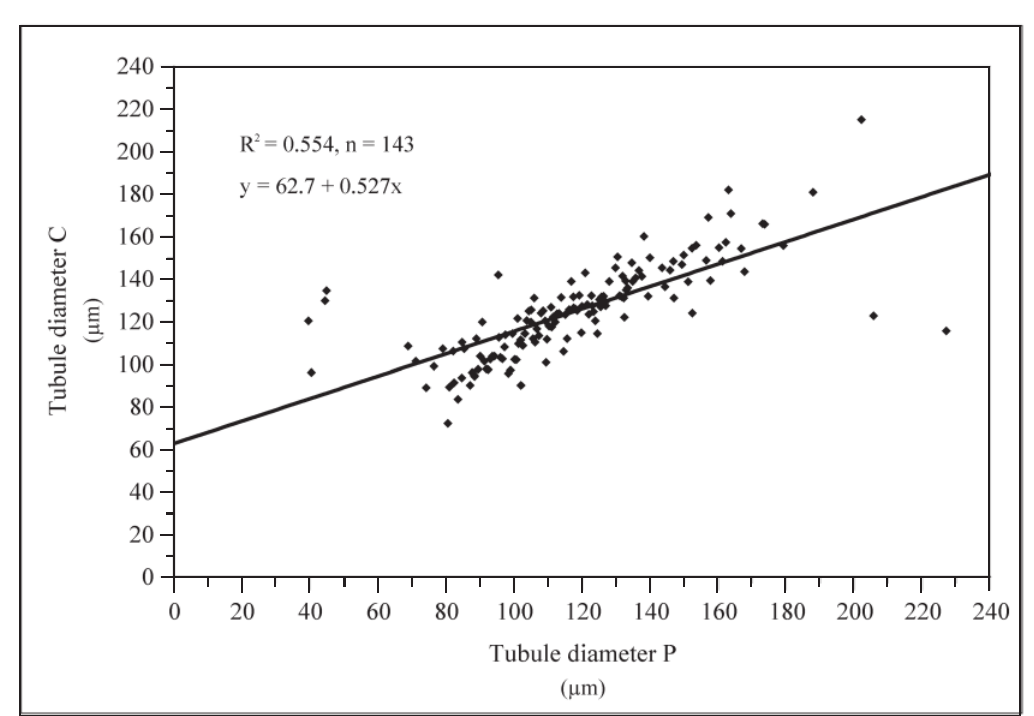
Fig. 1. Relationship between average seminiferous tubule diameters in center (C) and peripher- al (P) samples for mature animals.